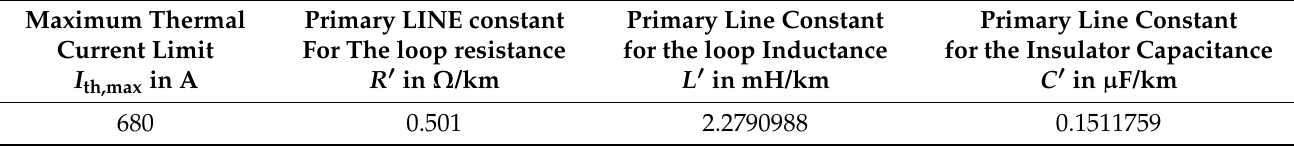
Table A2. Line data of the Cigré MV benchmark grid.